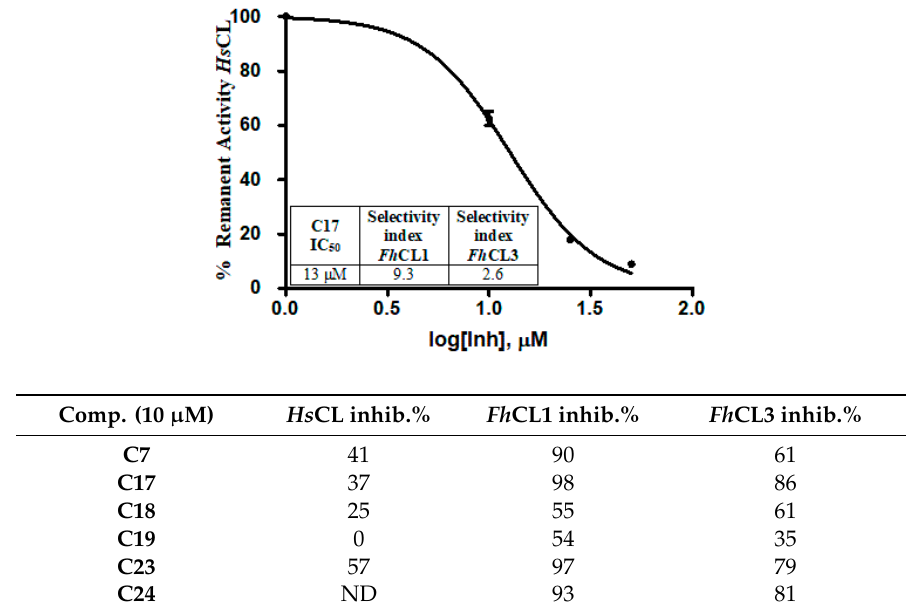
Figure 8. The table shows the comparison of the inhibition percentage of each compound at 10 µM for human cathepsin L ( Hs CL) and the Fasciola hepatica enzymes. The standard deviation is less than 10% for each compound. In the graphic, a dose-response curve for C17 was performed, and the IC 50 and selectivity index for the parasite enzymes were calculated.